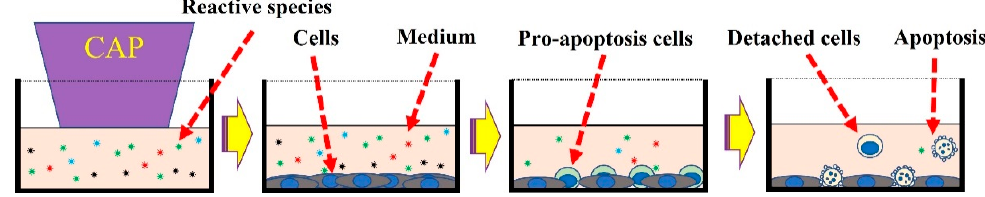
Figure 2. Schematic illustration of the indirect CAP treatment based on CAP-activated medium in vitro. Here, the feature of apoptosis is used to represent cell